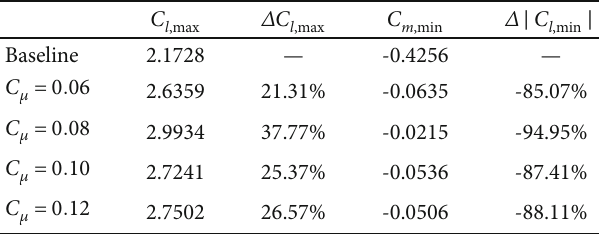
Figure 12: Lift and moment coe ffi cients of an OA212 CFJ airfoil with di ff erent values of C Table 1: The variation of the peak values of the lift and moment coe ffi cients of the airfoil with di ff erent values of C μ